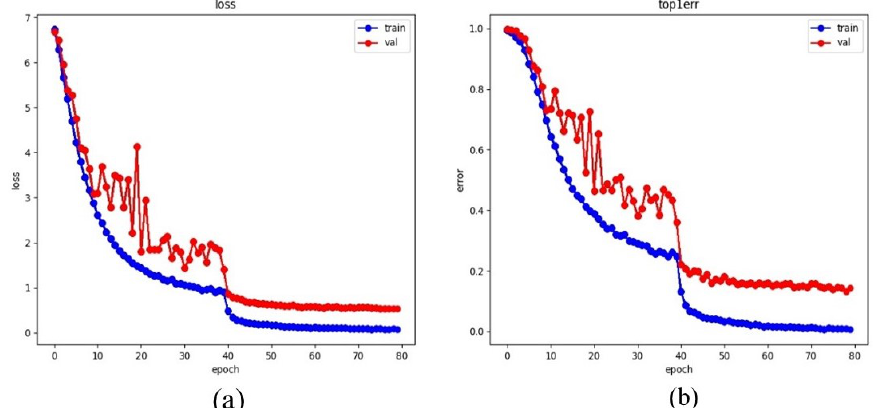
Figure 11. Feature extraction network training results. ( a ) Training Loss. ( b ) Top1